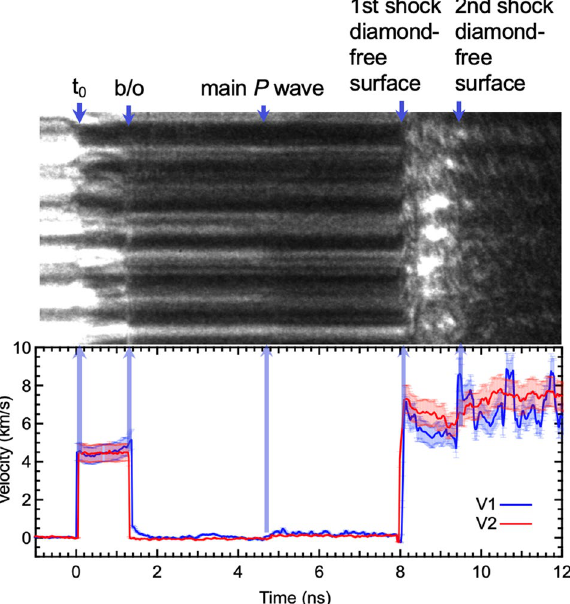
Figure 5. Velocimetry data from reverberation compression of water to ~ 200 GPa. Example raw VISAR1 (blue line & streak camera image) and VISAR2 (red line) data from Run 209 over a 28 μm region showing particle velocity (Up) of the diamond ablator (~ 4.5 km s −1 ) and free surface velocities (Ufs) from the 1st and 2nd shock arrivals at the diamond VISAR window (~ 7–7.5 km s −1 ) ranging from 4.4 to 6 km s −1 . Due to VISAR quality, the Up uncertainty is ~ 10%. Breakout (b/o) of the diamond elastic wave into the water layer occurs at ~ 1.5 ns, followed by the main pressure wave reaching the VISAR-side diamond-water interface at ~ 4.5 ns. The 1st and